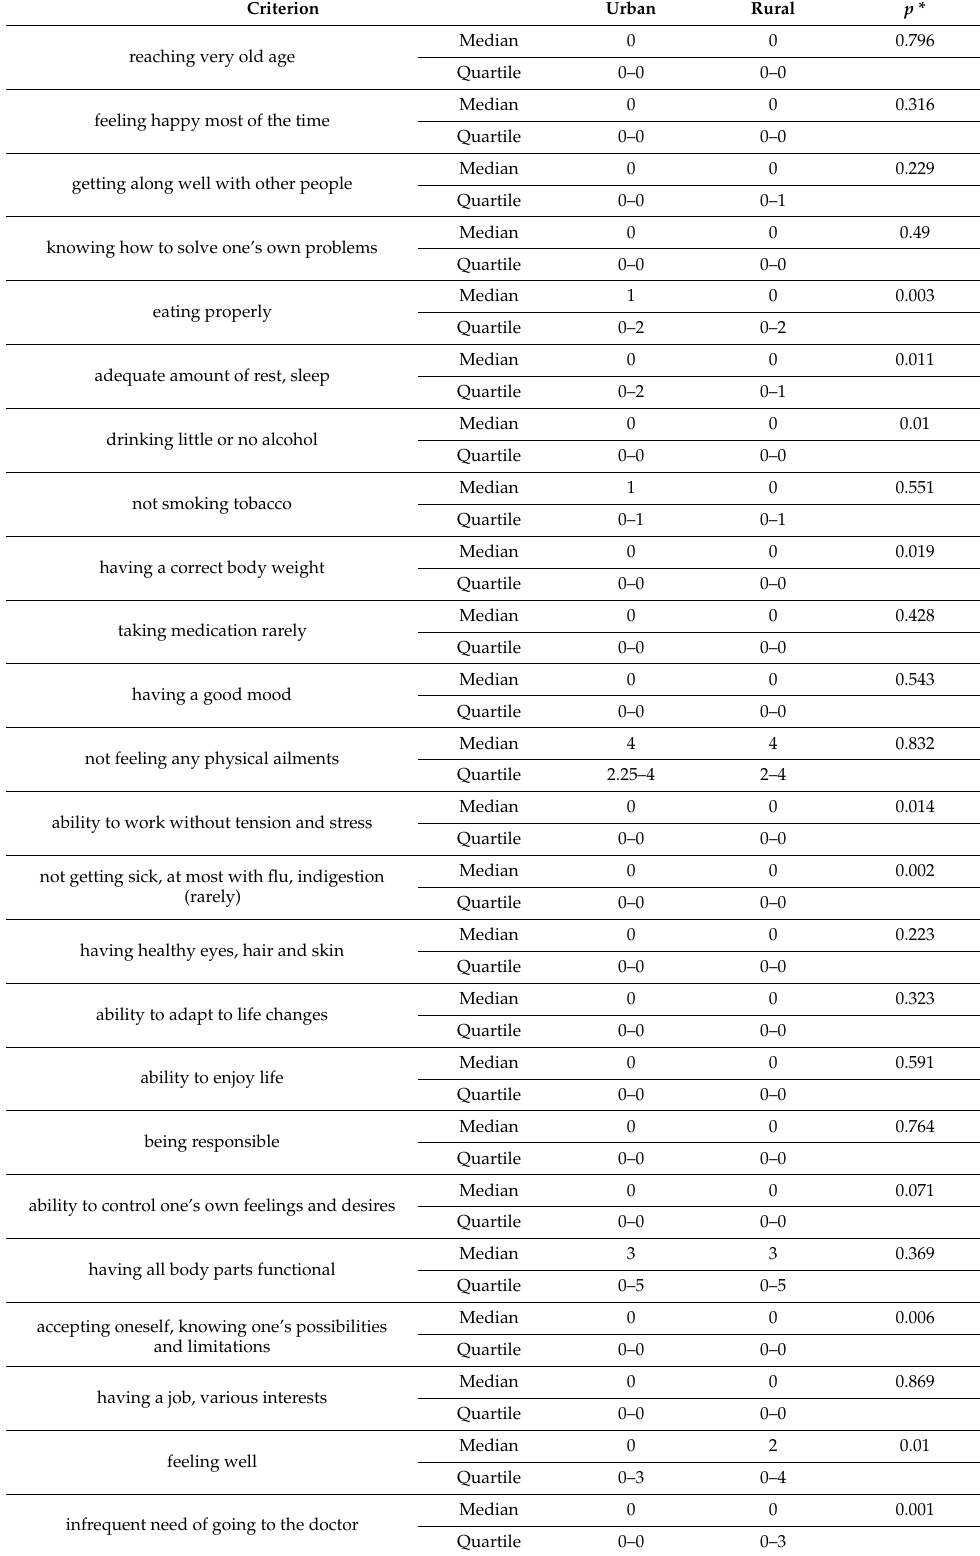
Table 6. Correlations of health statements with the place of residence of the